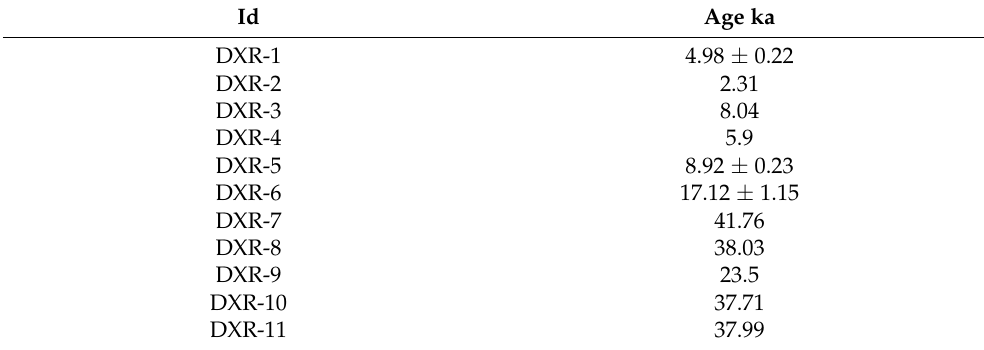
Table 5. Apparent age of geothermal